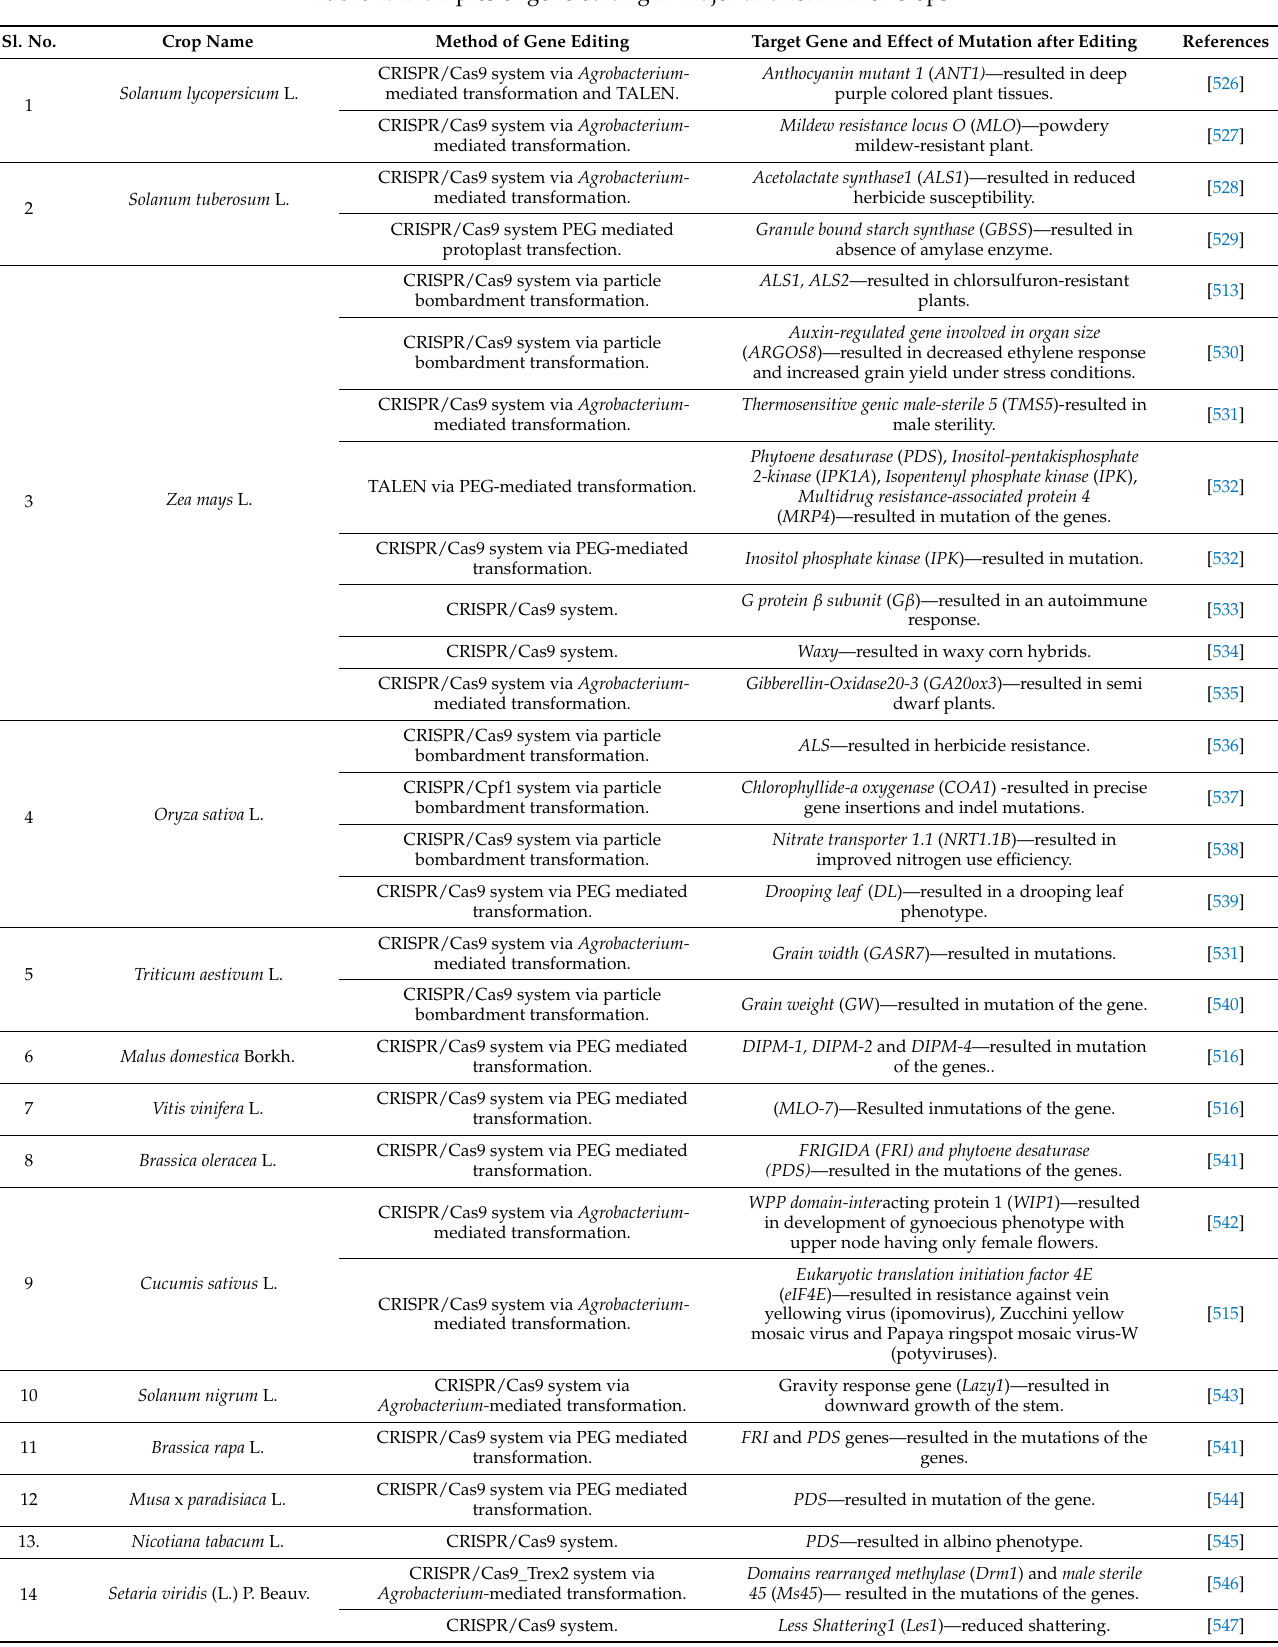
Table 4. Examples of gene editing in major and few minor